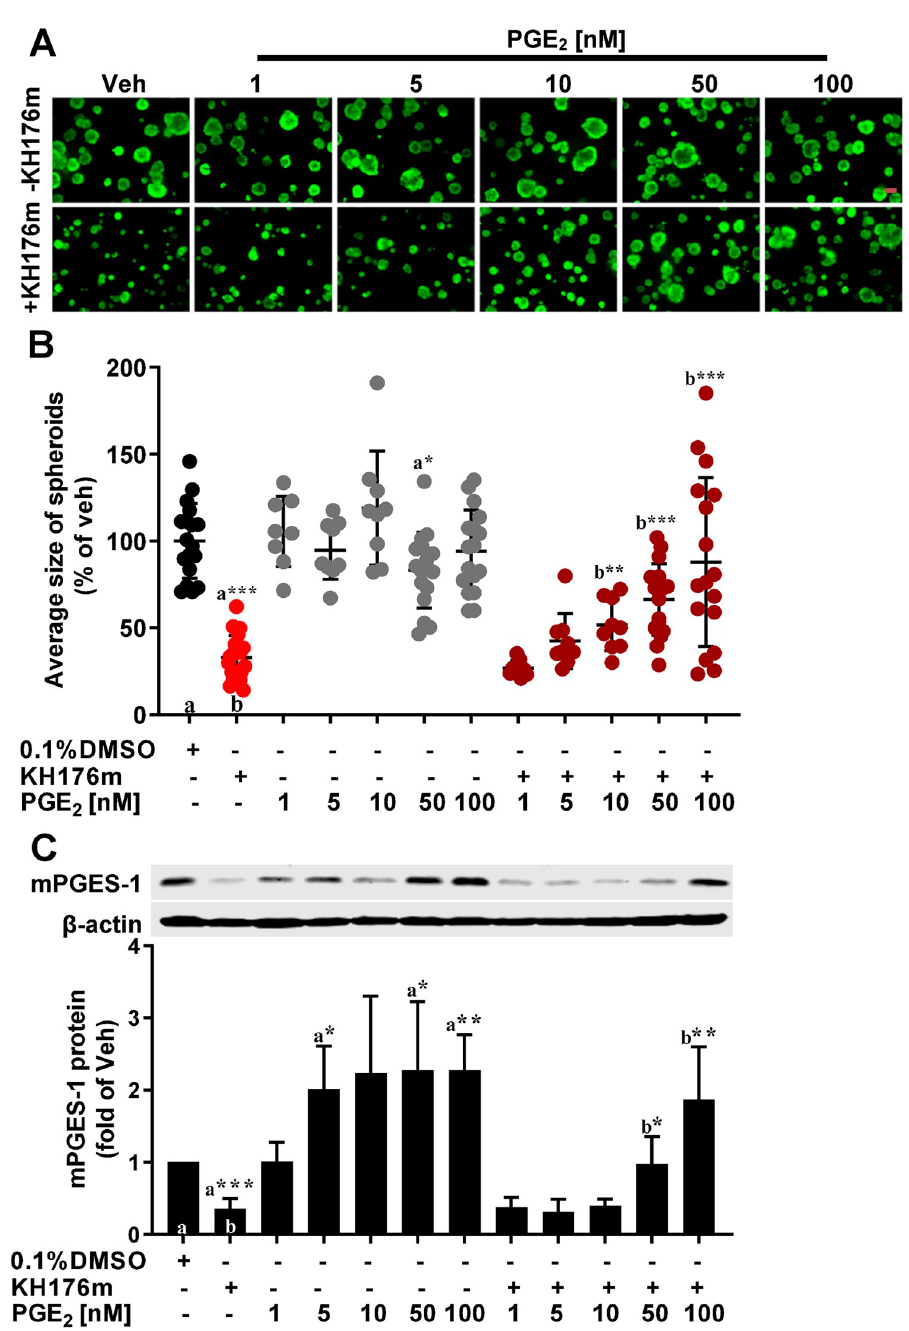
Fig 3. Inhibitory effect of KH176m on spheroid growth and expression of mPGES-1 is overcome by exogenous addition of PGE 2 . DU145 human prostate cancer cells were grown in Matrigel to induce spheroid formation and were treated with vehicle (0.1% DMSO) or 10 μ M KH176m and increasing concentrations of PGE 2 . (A) Representative images of spheroids generated from DU145 cells. Scale bars represent 100 microns; (B) Quantification of the results, each data point corresponds to the average size of DU145 derived spheroids (total area of spheroids / number of spheroids) from 1 image stack. Data are means ± SD (n = 9, from 3 independent biological repeats). (C) In parallel experiments protein was extracted from the DU145 derived spheroids and separated by SDS-PAGE. Expression of mPGES-1 was analyzed via western blot (n = 3). Veh: Vehicle. � , p < 0 . 05; �� , p < 0 . 005; ��� , p < 0 . 001 ; significant differences compared with the marked condition (a,b).